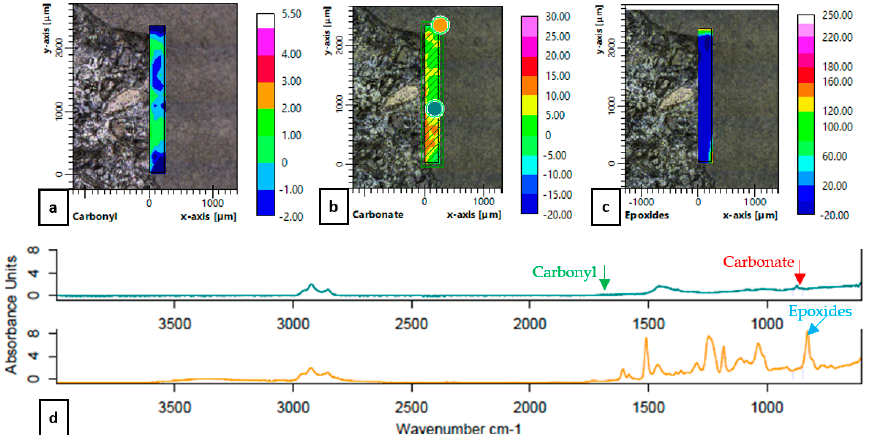
Figure 9. Chemical imaging of the GRAB sample (Area 2): carbonyl group ( a ); carbonate group ( b ); epoxides ( c ); spectral visualization of the selected points marked by colored dots in Figure 9b ( d ).